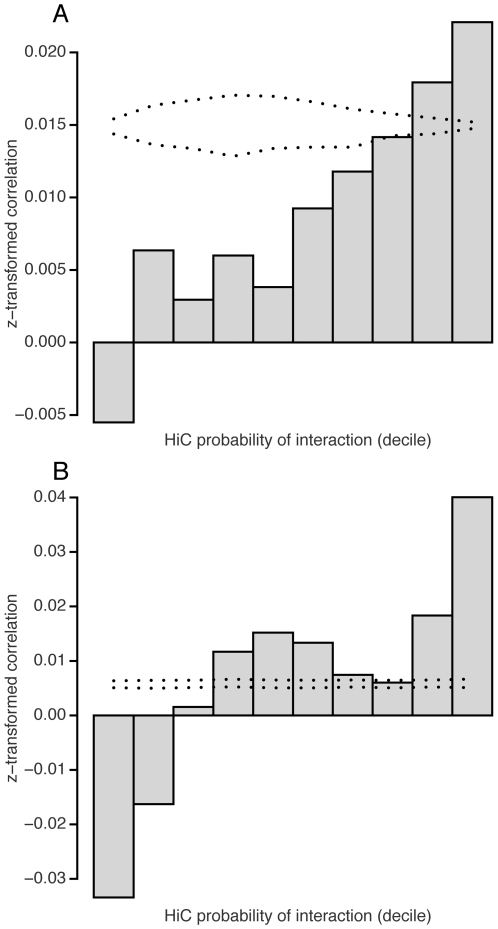
Genome-wide association between coexpression and spatial proximity.Barchart showing average z-transformed correlation coefficients for 10 groups according to the spatial proximity (“probability of interaction”) between the two genes. Dotted lines 95% interval calculated from permutation analysis. (A) Intra-chromosomal gene pairs (B) Inter-chromosomal gene pairs.